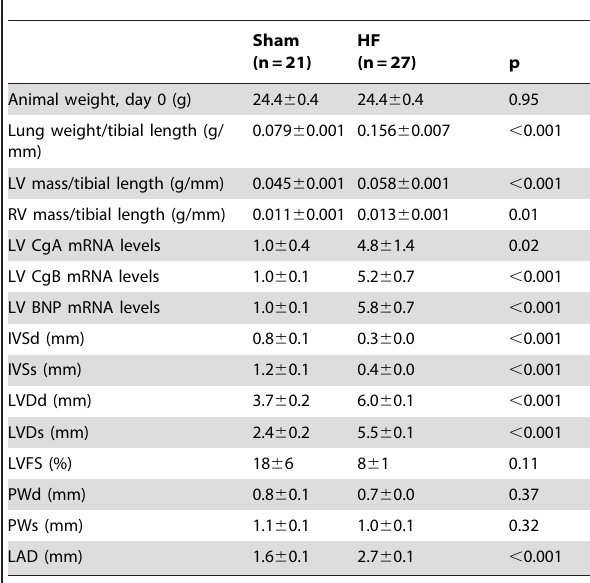
Table 1. Descriptive statistics of